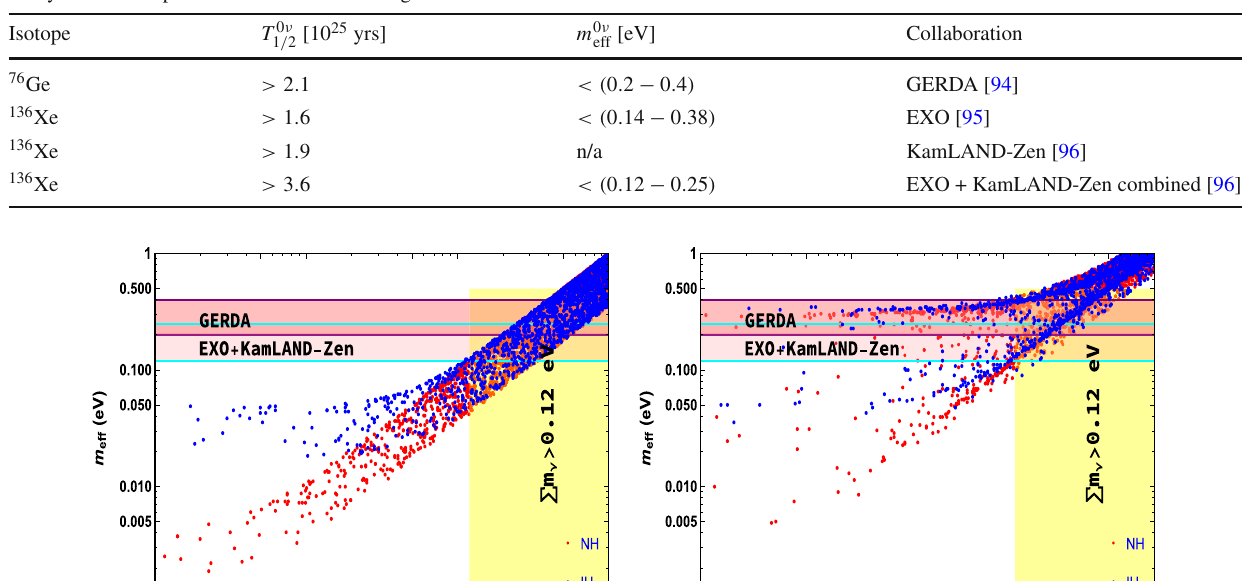
Table 6 The current lower limits on the half-life T 0 ν its on the effective mass parameter m 0 ν